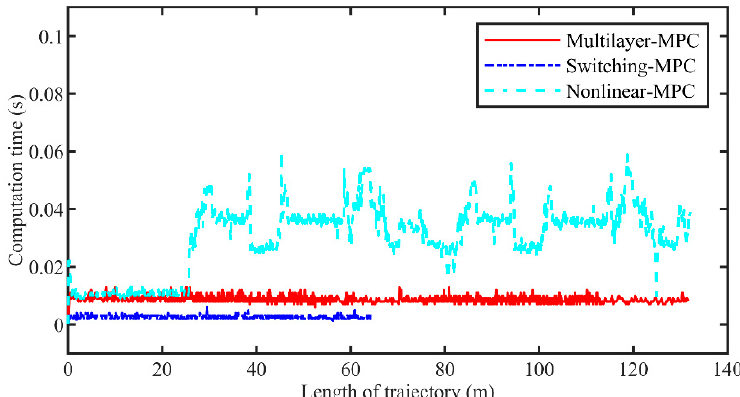
Figure 10. The computation time of the comparison between controllers.